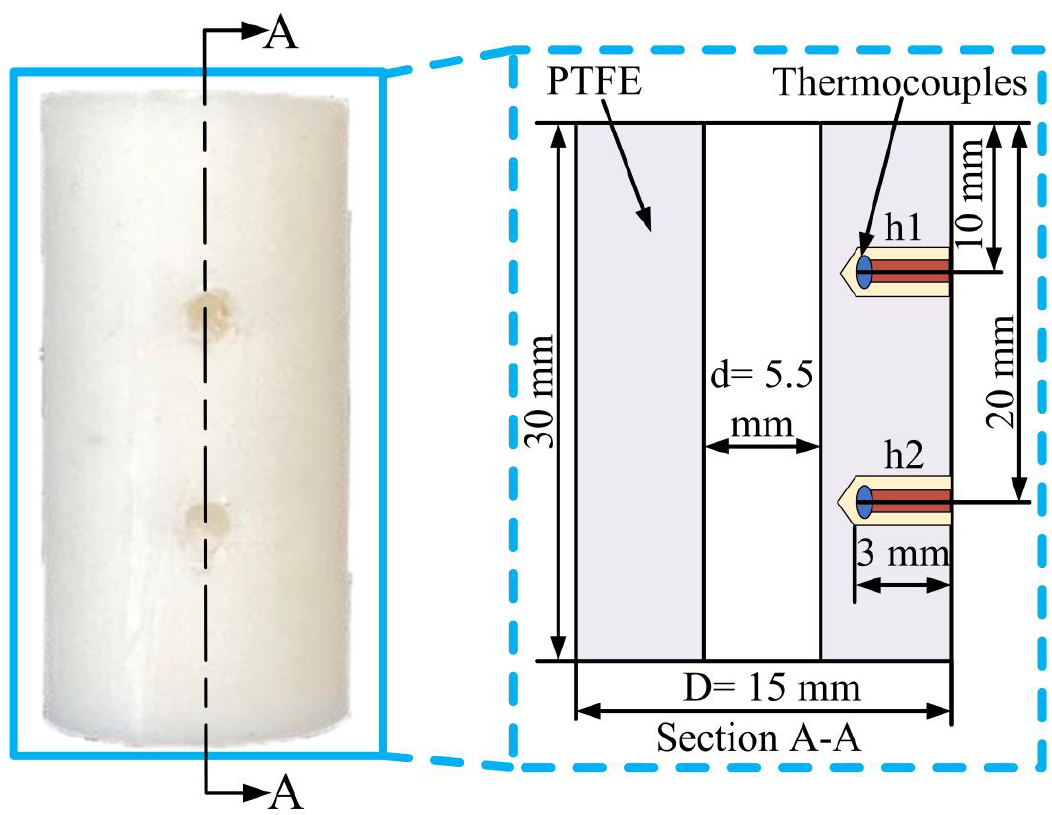
Figure 3. Thermocouple hole size and preset position.